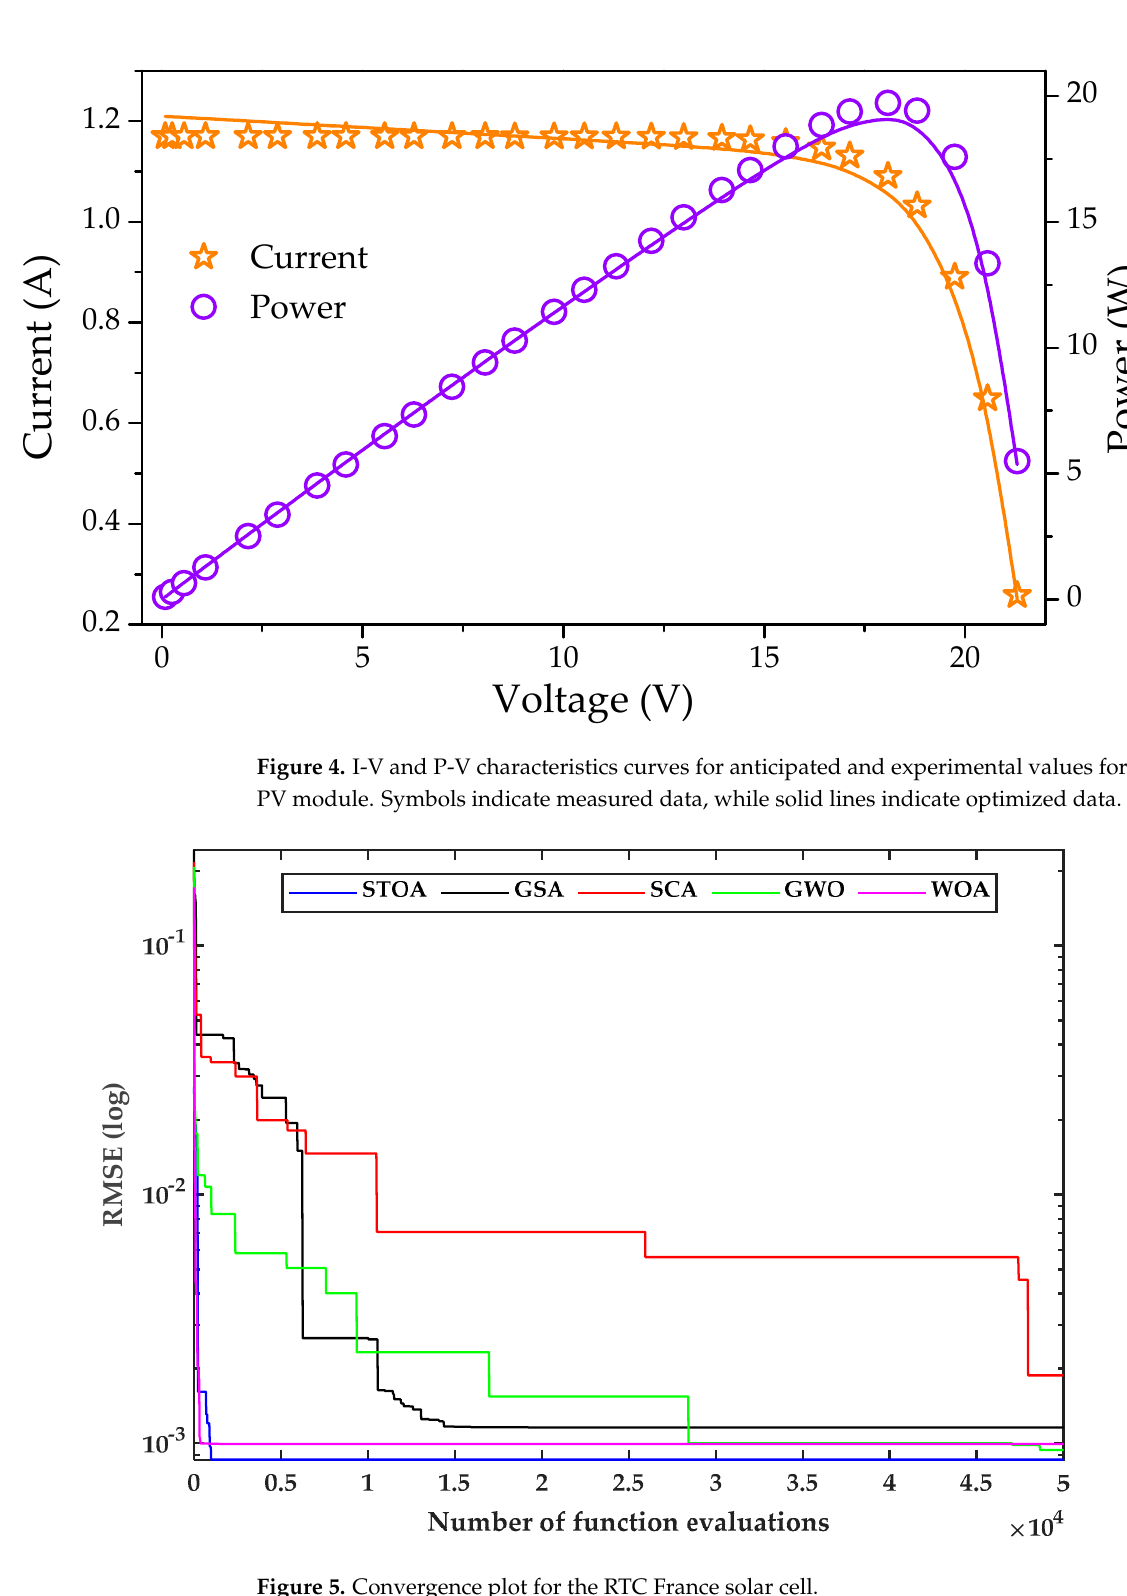
Figure 6. Convergence plot for the SS2018 PV module. 4.4. Statistical and Robustness Analysis This subsection offers statistical assessments of the mean, minimum, maximum, and standard deviation (SD) of RMSE for all recently created strategies. The accuracy and re- liability comparison of the various algorithms in 30 runs is summarized in Table 6. The RMSE mean and standard deviation were calculated to investigate the durability of the parameter estimation algorithms. According to the statistical data presented in Table 6, the STO is found to be the most precise and trustworthy parameter optimization tech- nique.